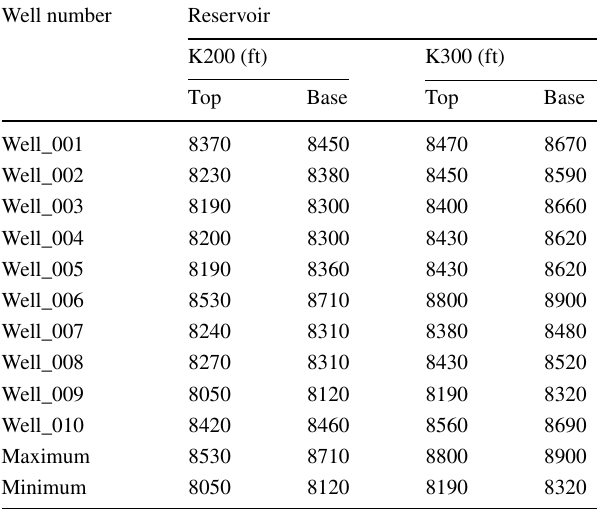
Table 1 Summary of reservoir tops and bases and thicknesses at each well